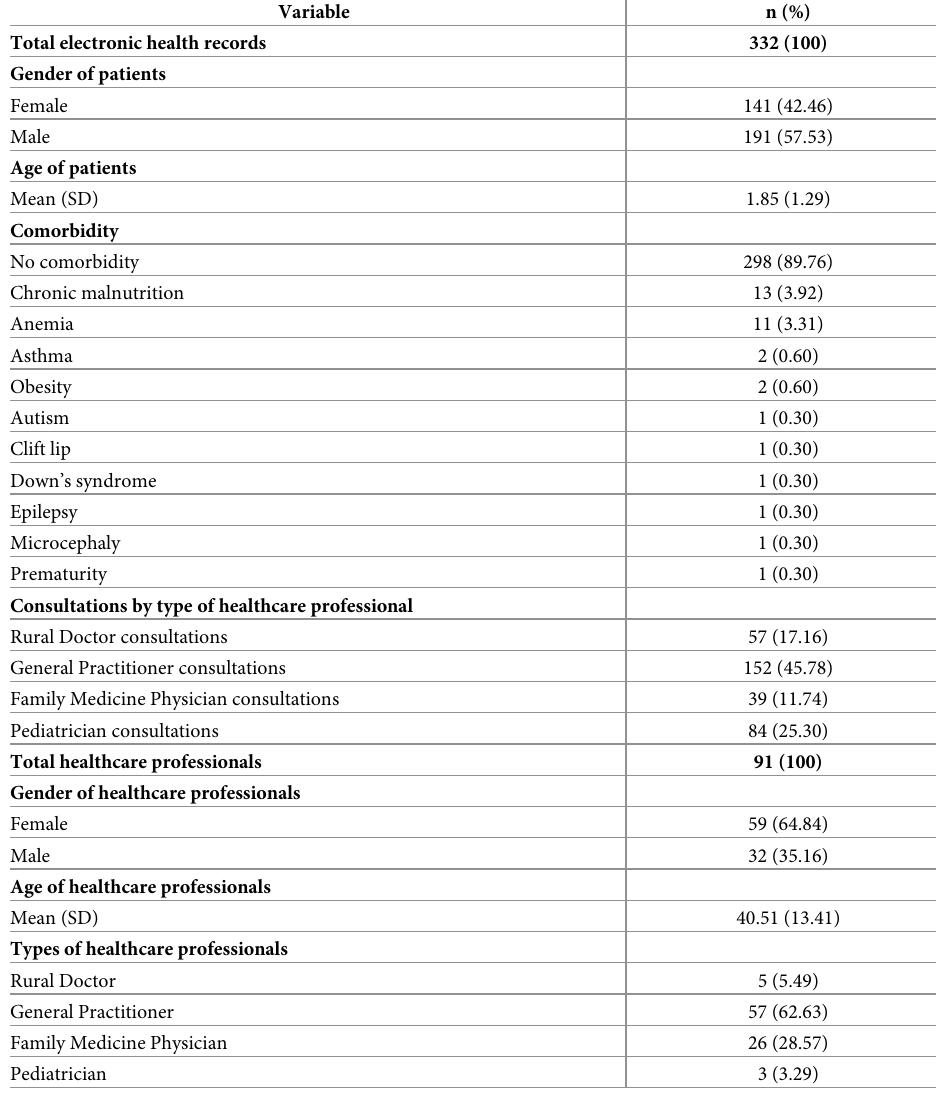
Table 1. Characteristics of the